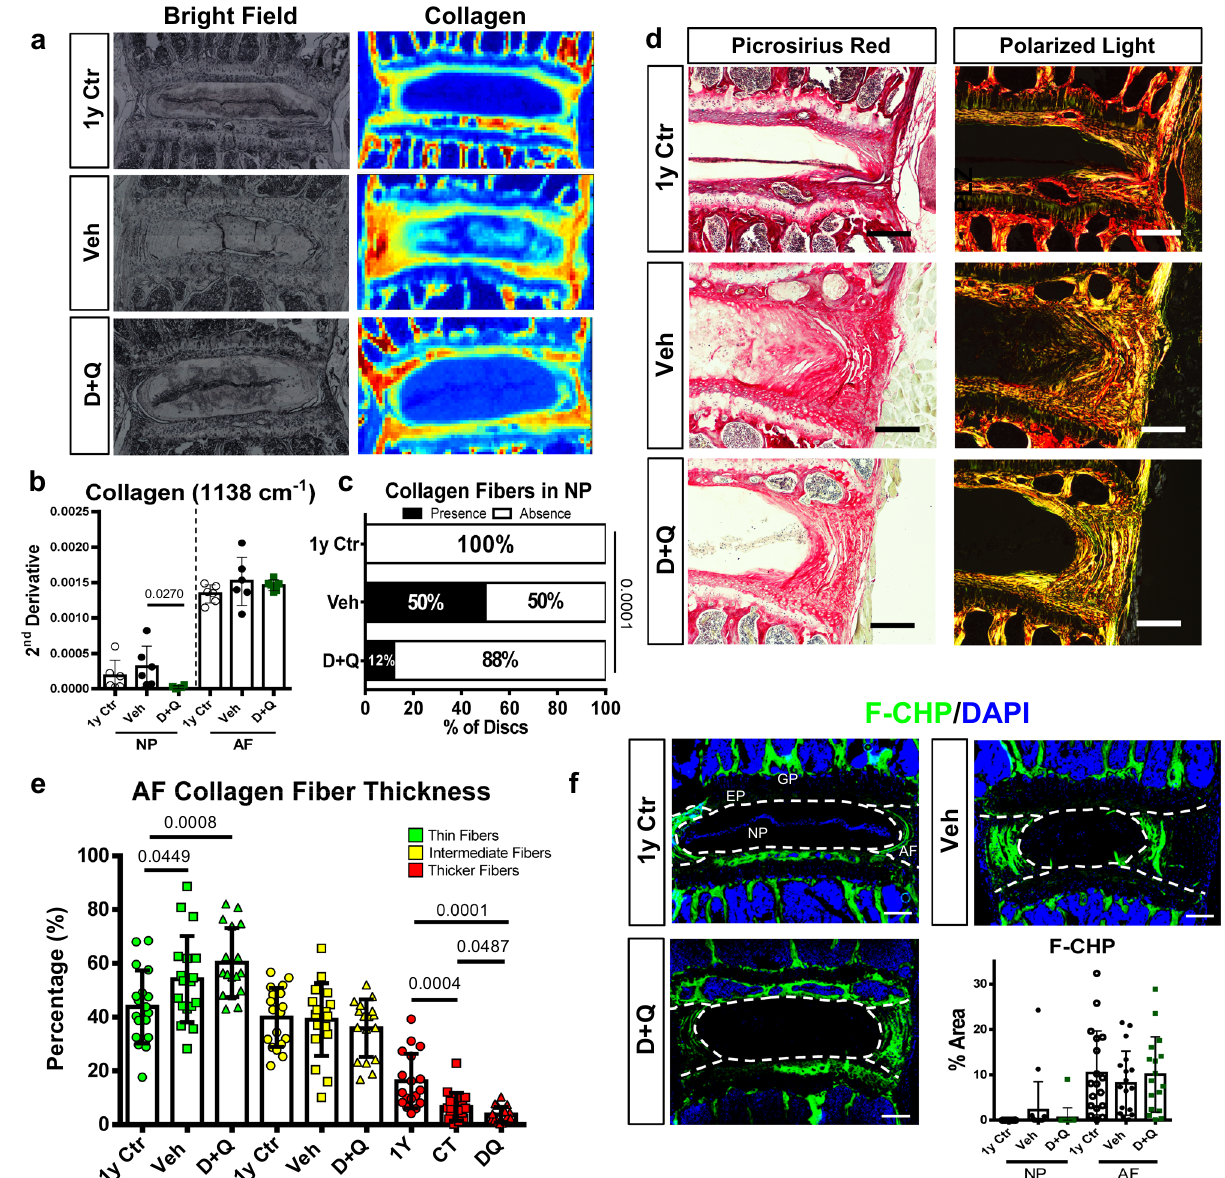
Fig. 4 D + Q treatment results in lower incidence of NP fi brosis. a Bright fi eld and chemical map of mean second-derivative peaks for collagen (1338cm − 1 ). Red: high relative absorbance; yellow: intermediate relative absorbance; blue: low relative absorbance. b Quanti fi cation of mean second-derivative peaks for collagen (1338cm − 1 ). c Quanti fi cation of the percentage of presence/absence of collagen fi bers within the NP compartment. d 1-year Ctr, Veh and D + Q lumbar discs showing collagen fi ber organization under bright fi eld and polarized light (scale bar = 100 μ m). e Quanti fi cation of collagen fi ber thickness distribution and proportion in the AF. f Denatured collagen, measured by a collagen hybridization peptide (CHP) biding assay (scale bar = 200 µ m). Two-tailed ANOVA or Kruskal – Wallis tests were used as appropriate; n = 6 mice/group, 2 – 3 levels per mouse were analyzed. Data are represented as mean±SEM. Source data are provided as a Source Data fi